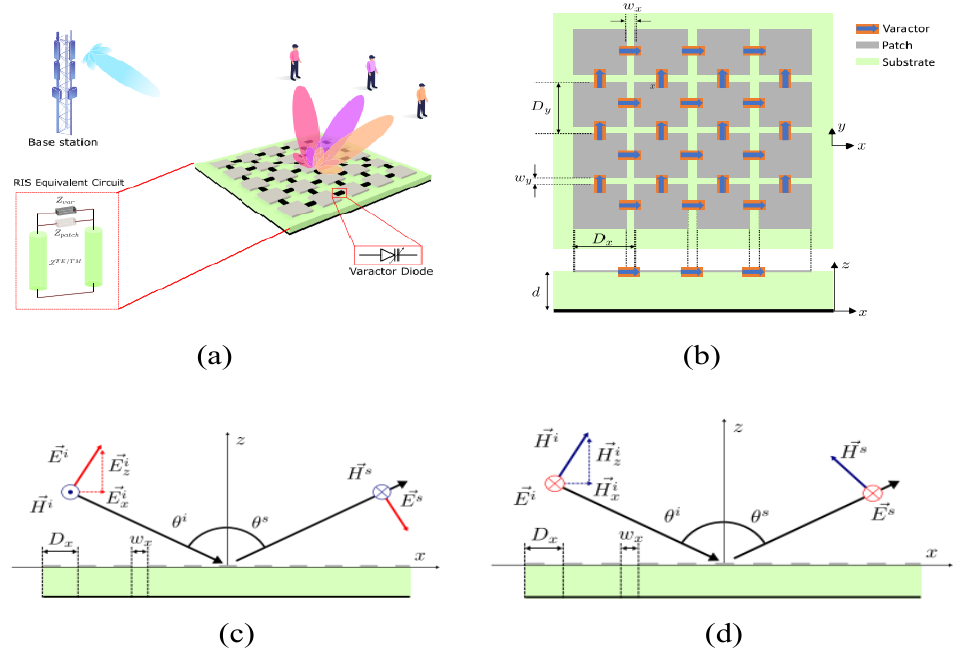
Figure 14. ( a ) Layout of RIS surfaces. ( b ) Geometry of reported intelligent surfaces loaded with diodes. ( c ) Parallel polarization. ( d ) Perpendicular polarization. Reprinted from Ref. [153].